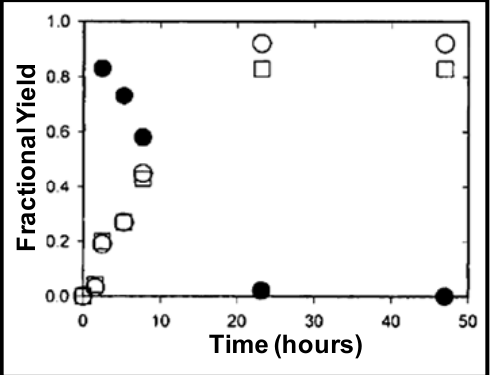
Figure 13. Decomposition of 2,4-dihydroxyacetophenone ( ● ) to resorcinol ( □ ) and acetic acid ( ○ ) in water at 250 °C [68].